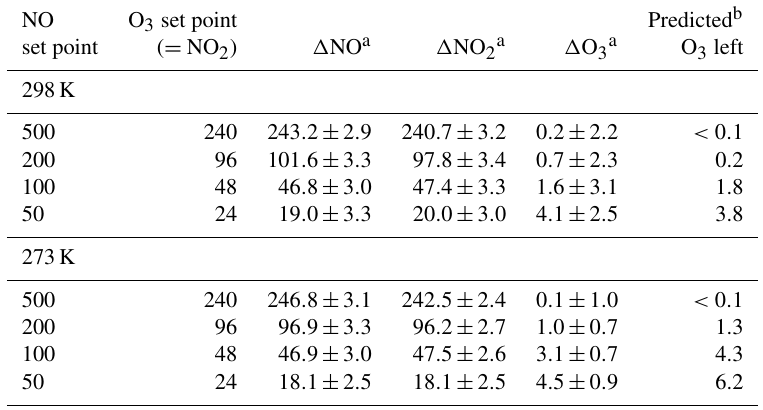
Table 4. O 3 , NO, and NO 2 measured at the output of a Model 714 for the NO and O 3 set points given in columns 1 and 2. The pressure was 830mbar. All units are in parts per